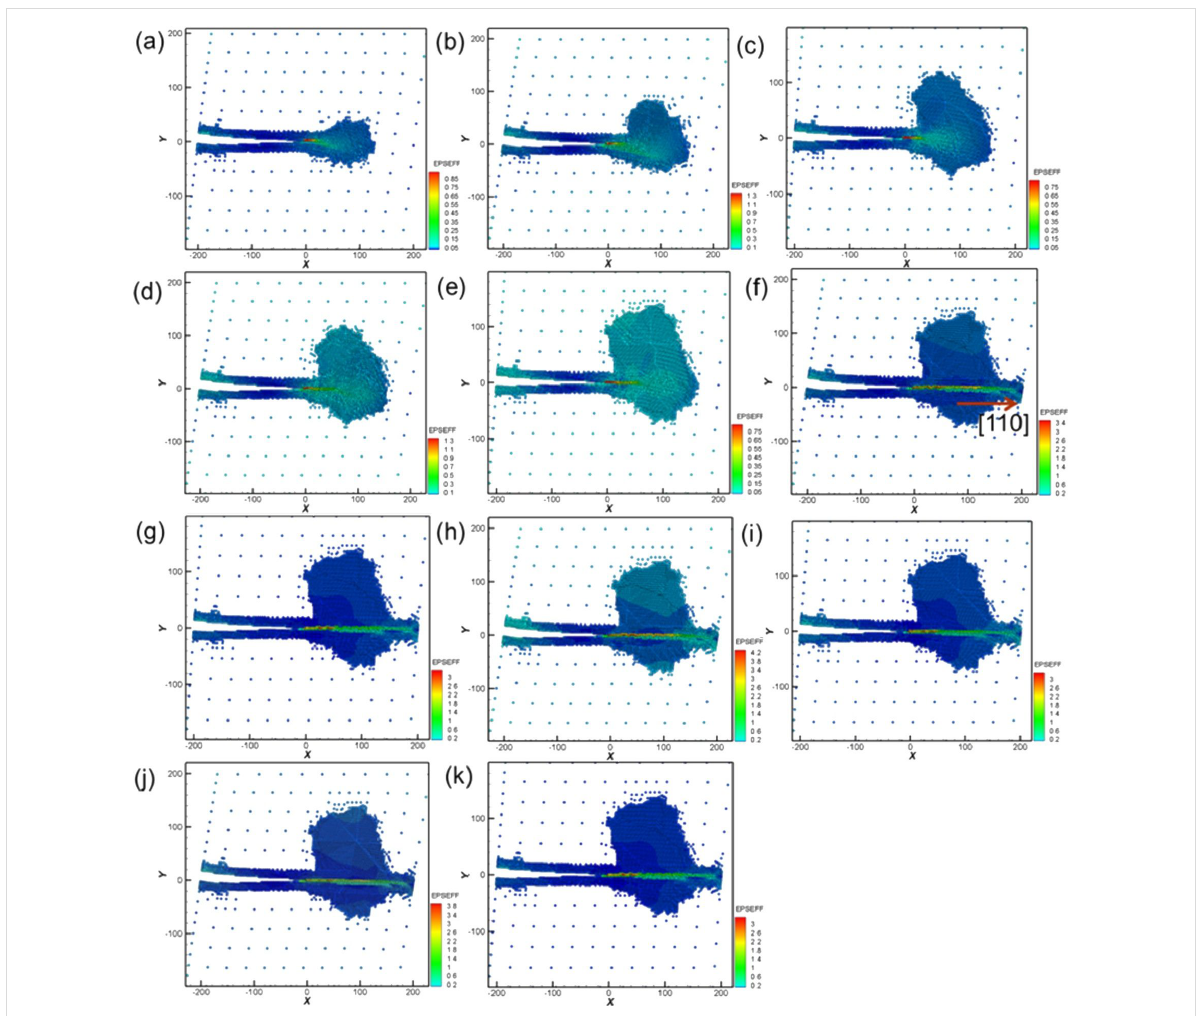
Figure 16: Crack growth and expansion diagrams of Fe corresponding to the observation positons a–f annotated in Figure 15.